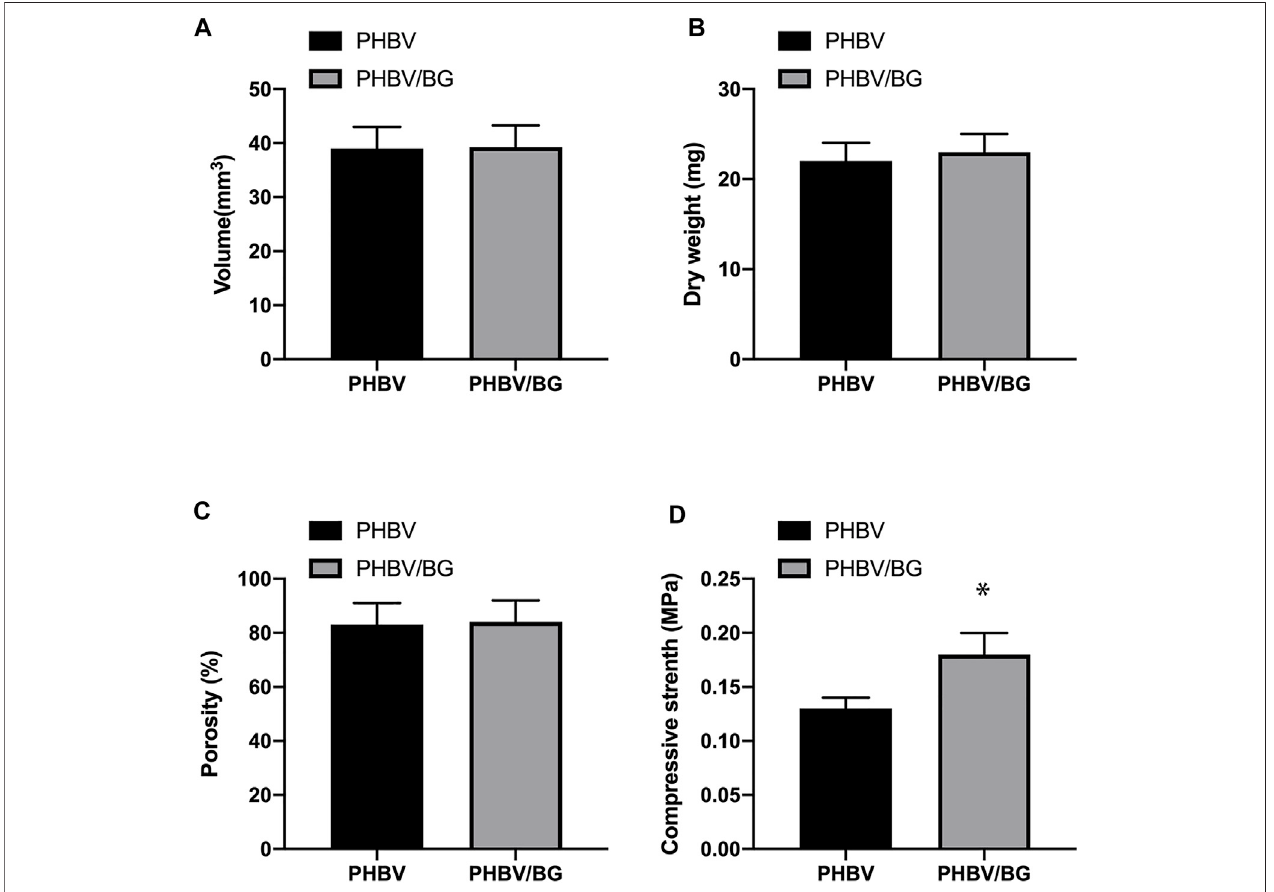
FIGURE 2 | Characterization of PHBV and PHBV/10%Bioglass 3D porous scaffolds. The PHBV and PHBV/10%Bioglass 3D porous scaffolds exhibited the same volume (A) and dry weight (B) and the same porosity (C) ( p > 0.05). The compressive modulus (D) of the CPC – PHBV/10%Bioglass constructs was greater than that of CPC – PHBV constructs ( p < 0.05).